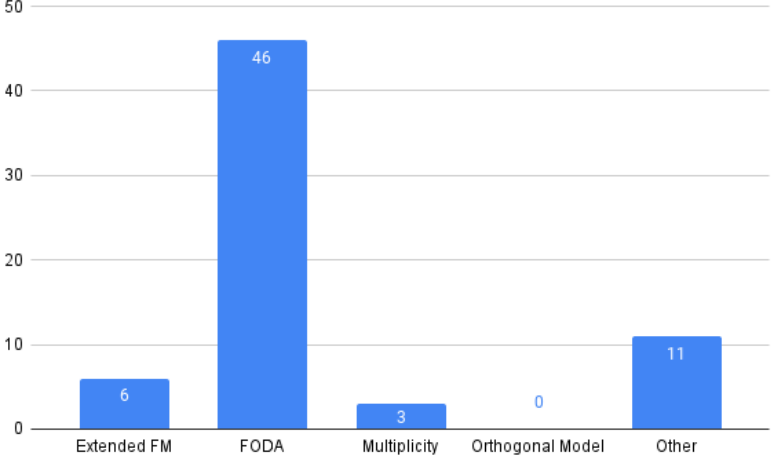
Figure 11. FMs used for each